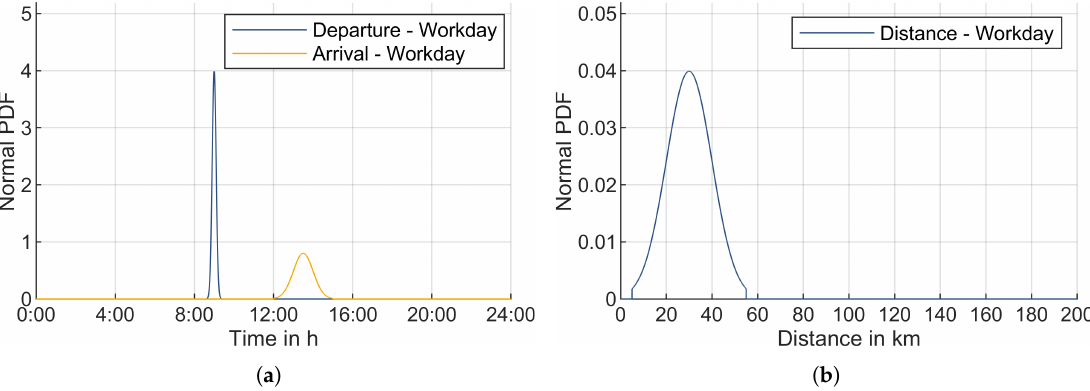
Figure A2. Probability distribution functions (PDFs) of the driving profiles for mobility profile 2nd Car on a workday. ( a ) PDF of the normal distribution used to model the departure and arrival times at home on a workday (Monday–Friday) for mobility profile 2nd Car ; ( b ) PDF of the normal distribution used to model the driving distance on a workday (Monday–Friday) for mobility profile 2nd Car